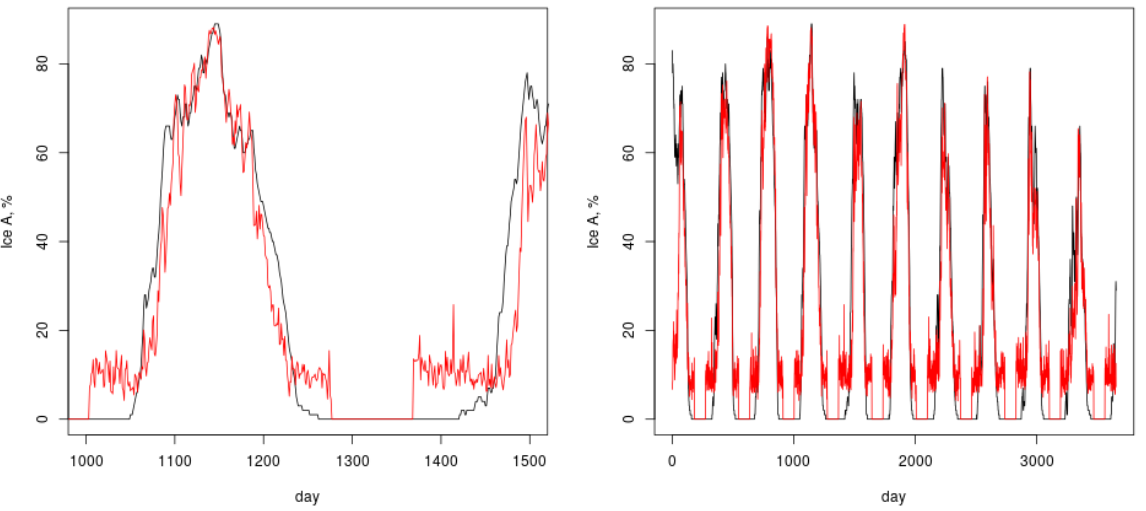
Figure 4. Daily sea-ice concentration for the White Sea for the time-span 2008–2017 ( left side ) and about one year (days 1000–1500, starting from 1 January 2008) ( right side ). The red curve is for the data, the black one is for the